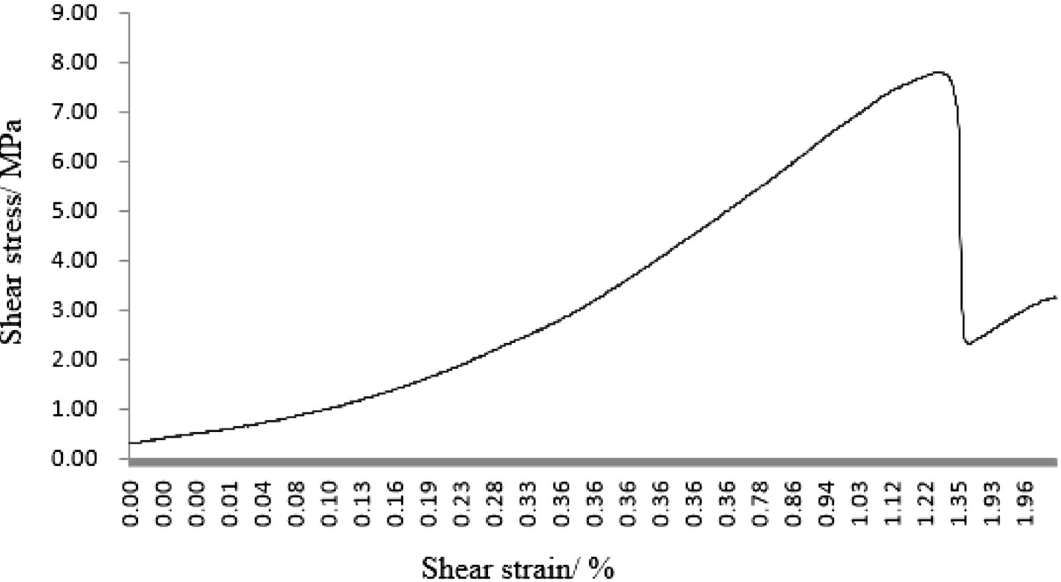
Figure 35. The fifth fracture mode rock shear stress-shear strain